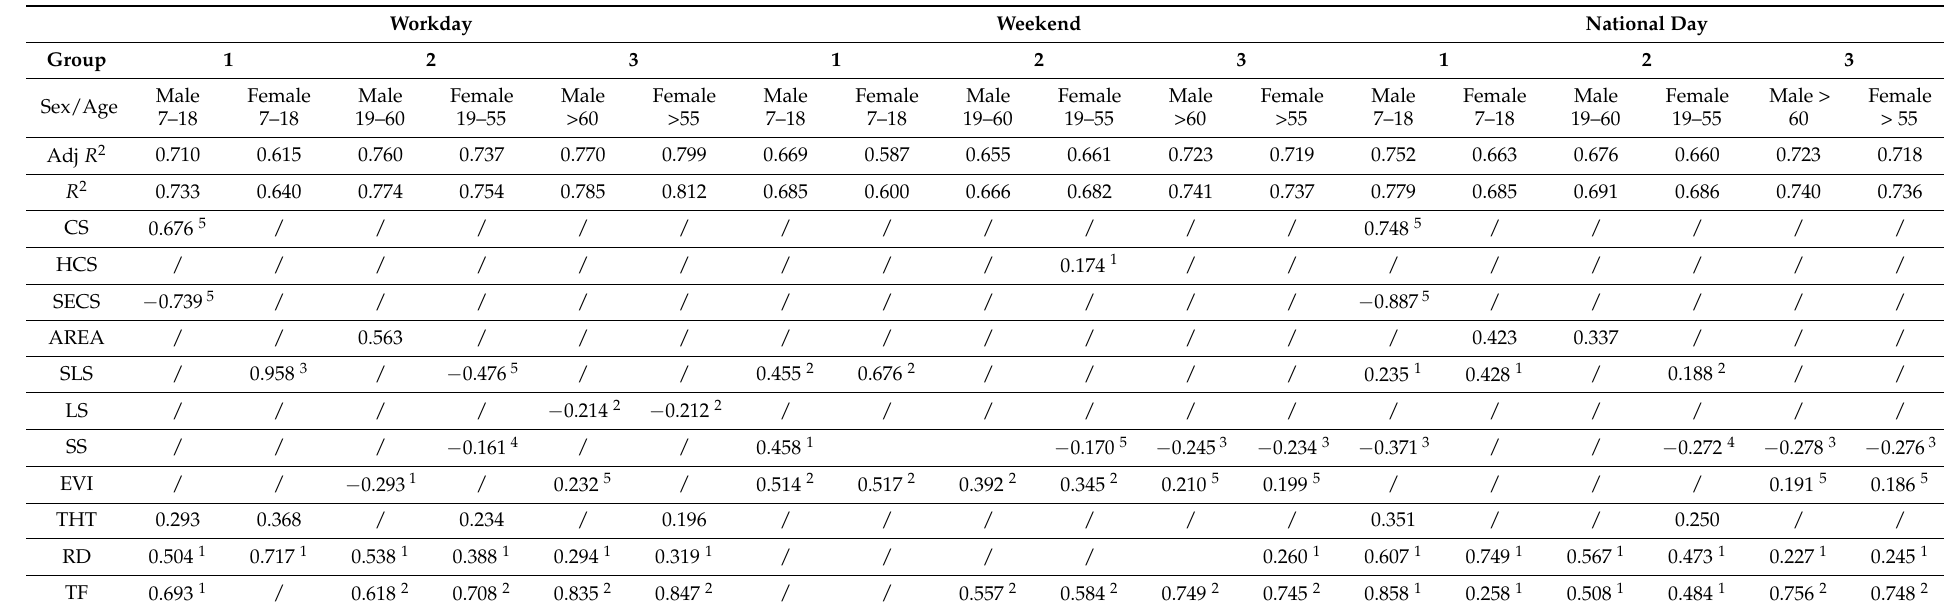
Table 3. The best regression model for each age and gender